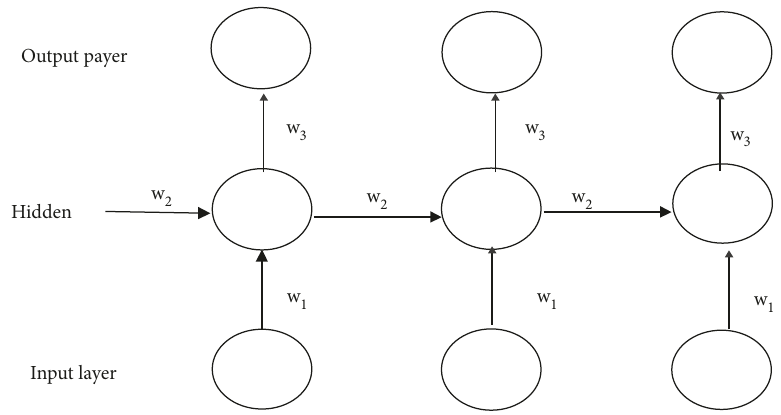
Figure 2: A RNN architecture where all the weights in all the layers must be learned with time.